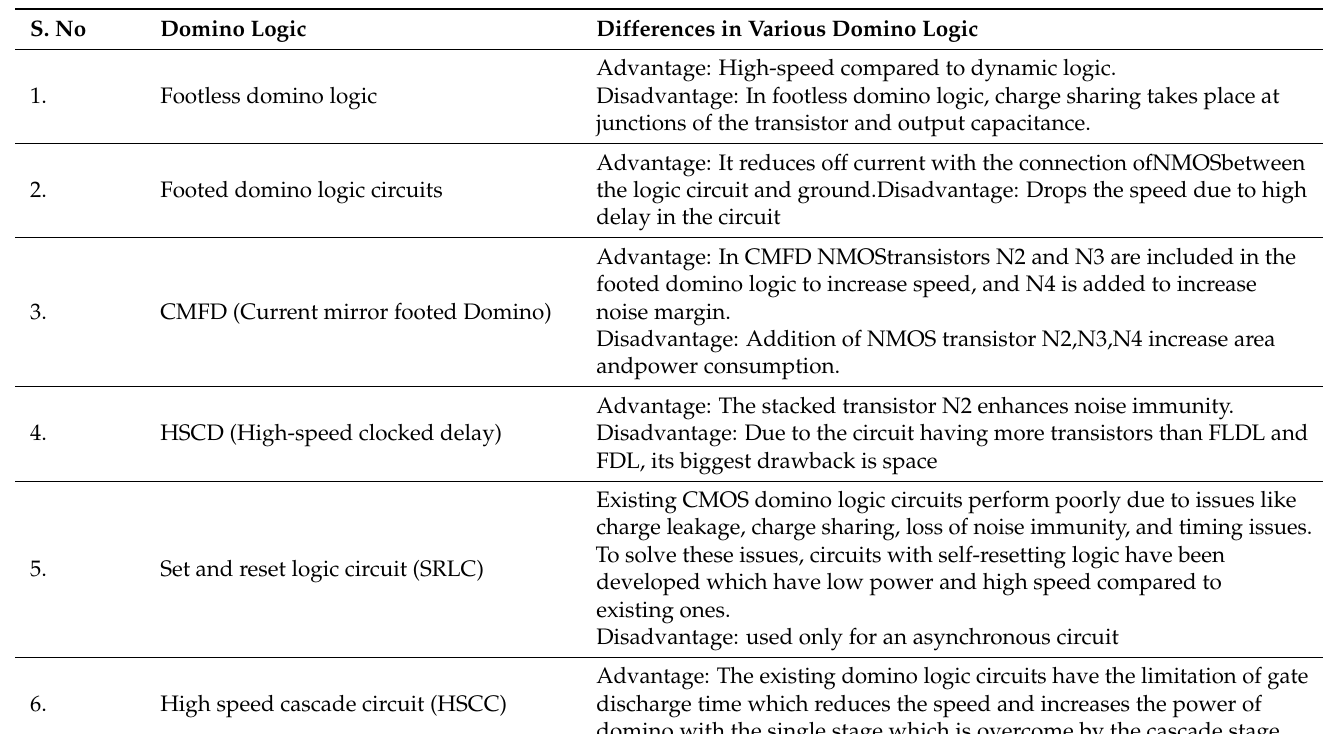
Table 3. Comparison of various types of domino logic